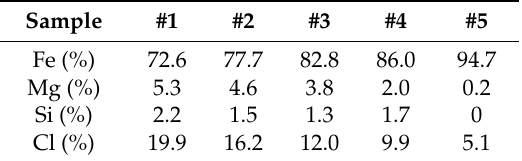
Table 2. Formulations of magnesium aminoclay (MgAC) and iron precursors in 90 mL volumes for preparation of MgAC-Fe 3 O 4 hybrid composites.